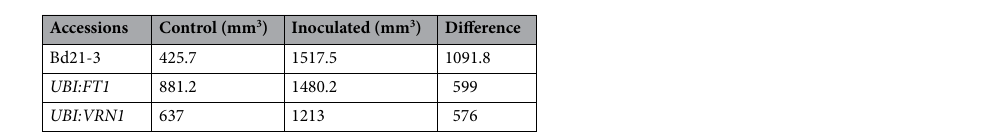
Table 2. Estimated root volume of B.distachyon wild type and transgenic lines from CT-Scanning